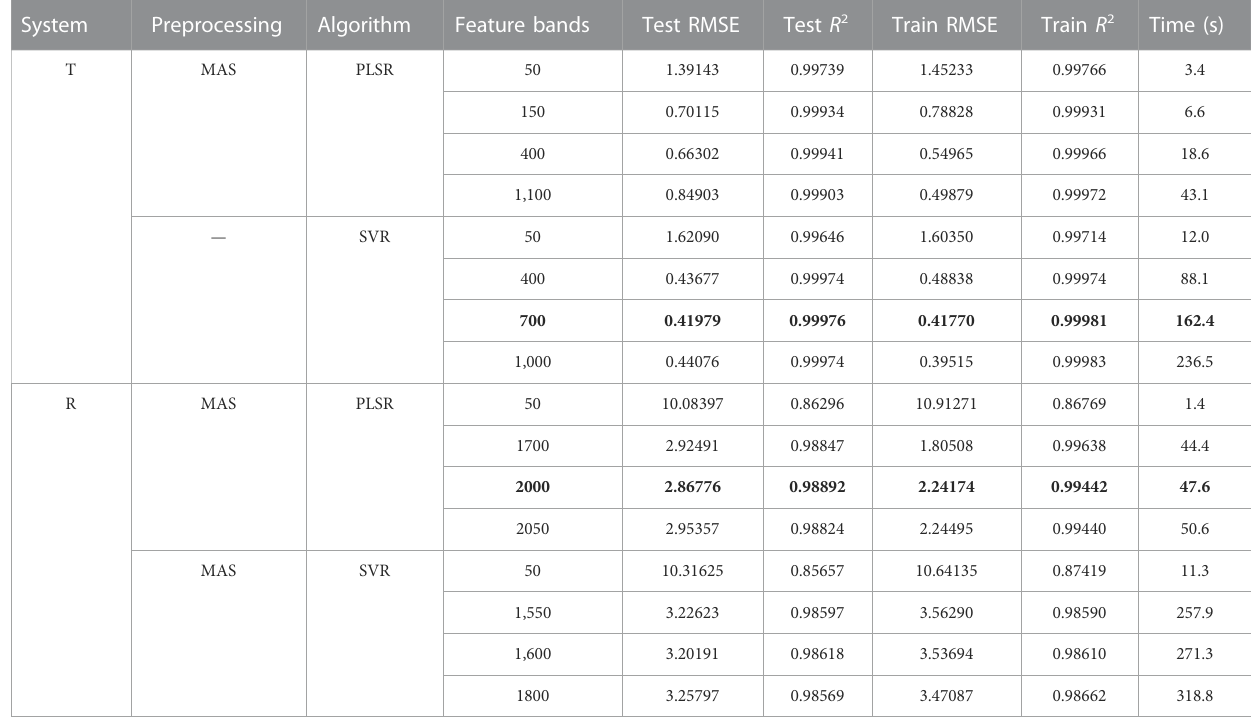
TABLE 6 Modeling results using different numbers of feature bands. System Preprocessing